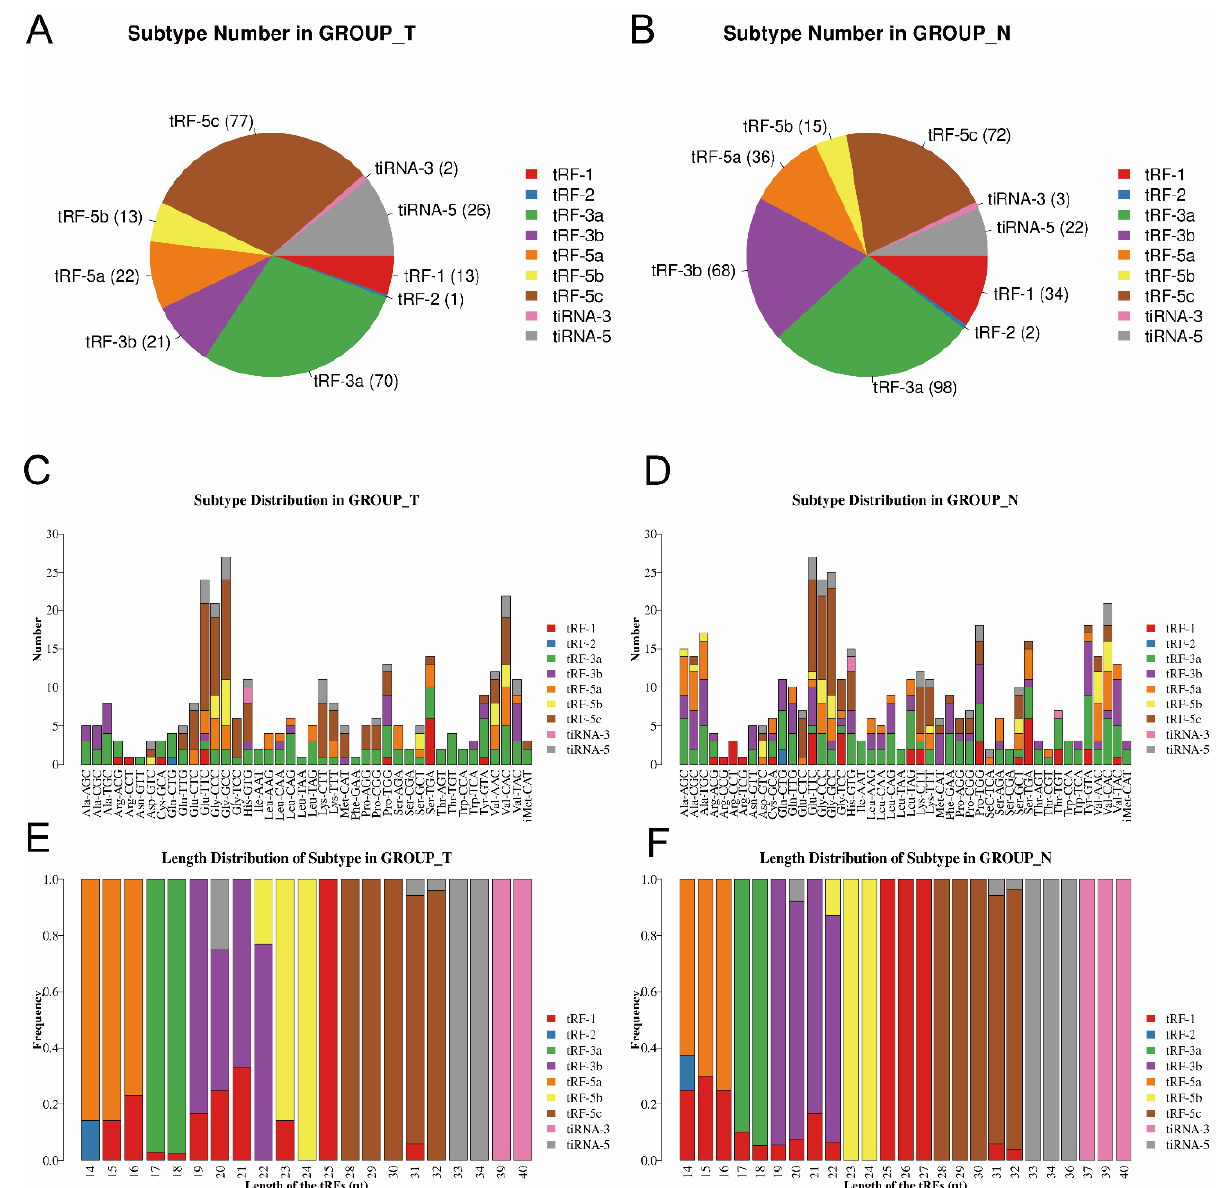
Figure 2. Stacked bar chart (T, tumor group. N, paracancer group). ( A , B ) Pie chart of the distribution of tsRNA subtypes in T group and N group. ( C , D ) Subtype number in T and N group. X axes: tRNA isodecoders; Y axes: the number of all subtype tsRNAs. The color: the subtype of tsRNAs. ( E , F ) Length distribution of subtype. The X axes: length of tsRNAs; Y axes: the frequency of the subtype; the color: the subtype of